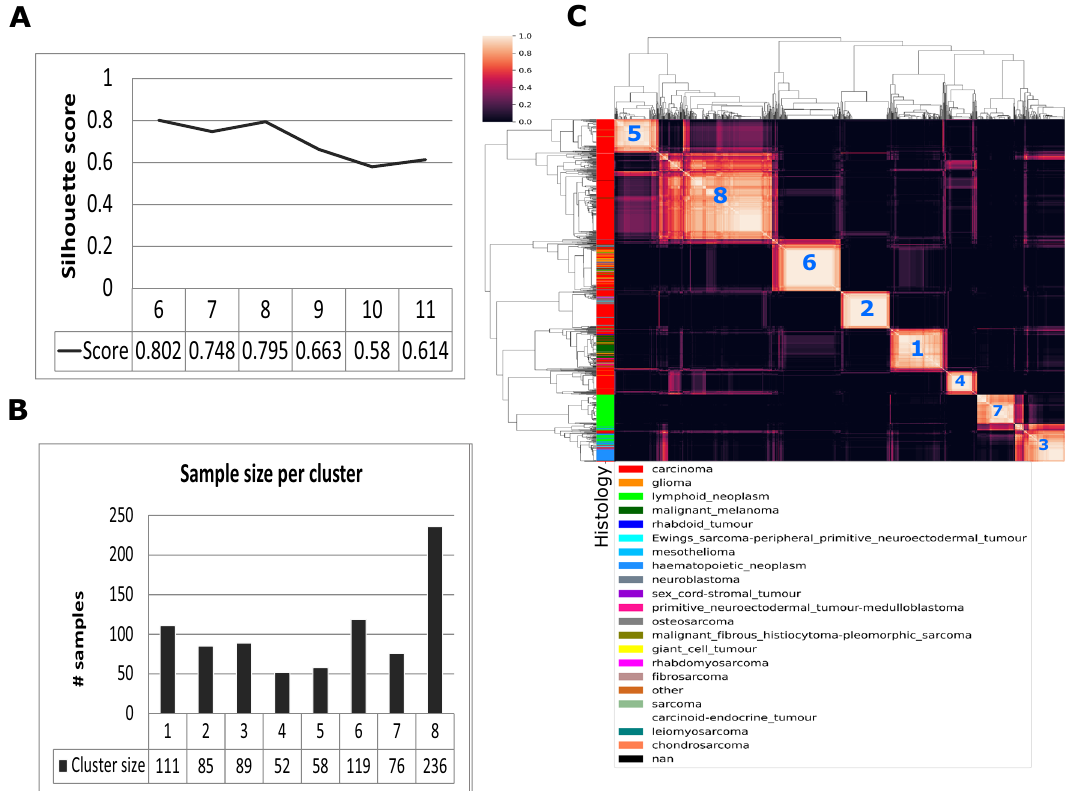
Figure 1. ( A ) Silhouette score for cluster sizes 6 to 11. ( B ) Number of samples in each cluster. ( C ) Consensus plot for cluster size